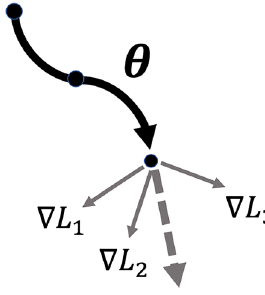
Figure 3. The optimization-based process for optimizing towards three tasks illustrated.